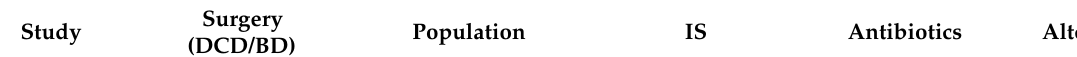
Table 2. Clinical studies in